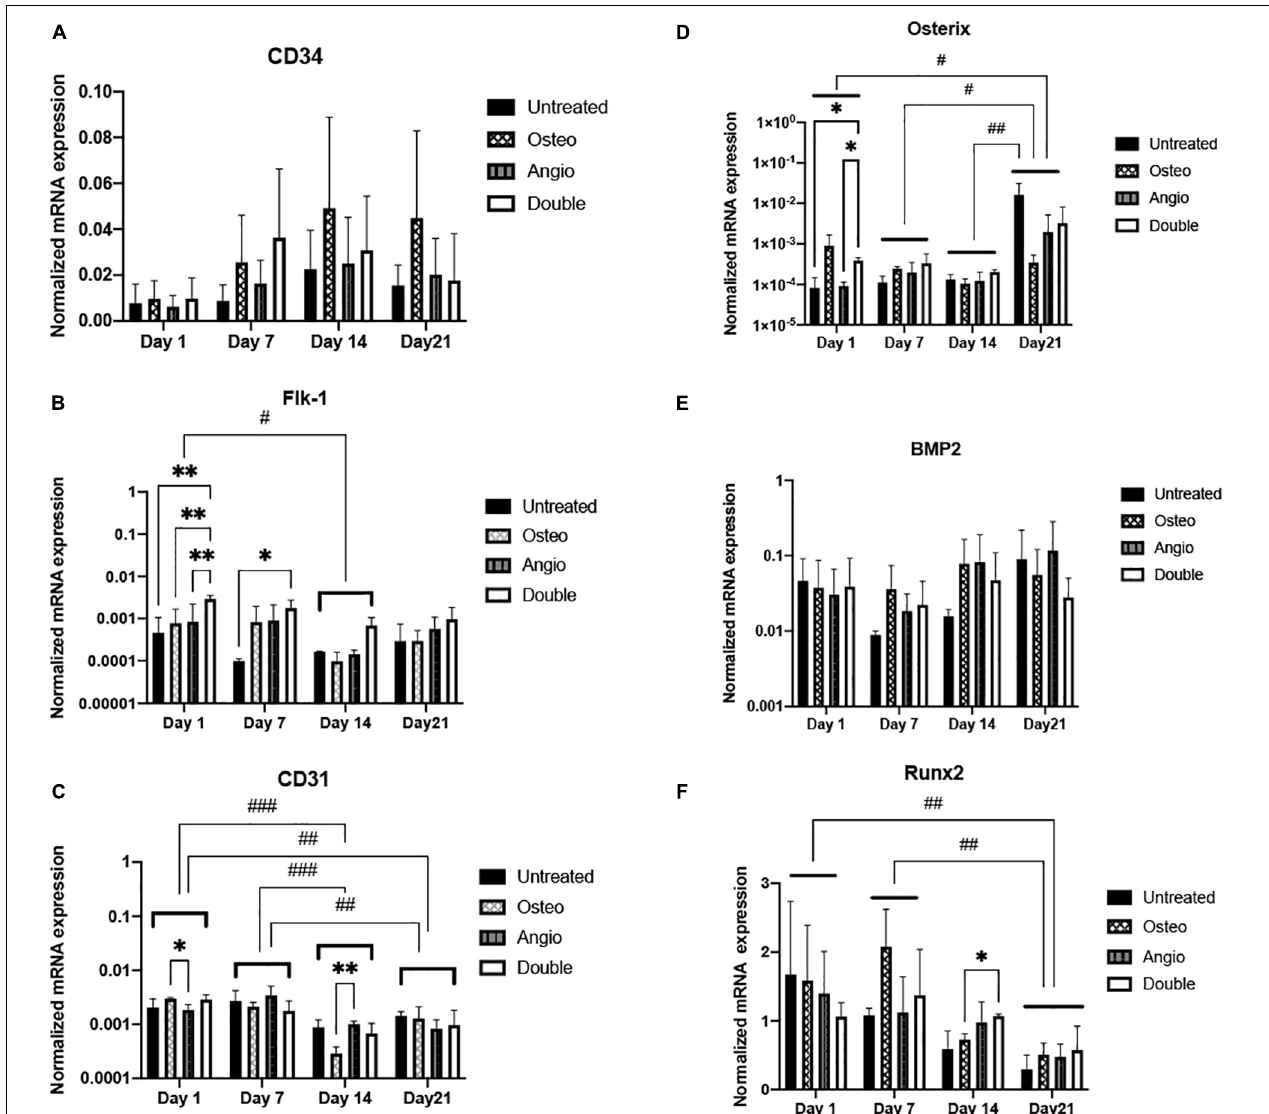
FIGURE 4 | All groups of ADSC-derived spheroids showed different dynamics of gene expression in angiogenic and osteogenic differentiation. (A) Expression of CD34 gene (early angiogenic differentiation marker) showed non-significant increase in all groups toward day 21. (B) Flk-1 (VEGF receptor 2 gene) expression decreased significantly in all groups on day 14 compared with that on day 1. (C) CD31 (mature endothelial cell marker) gene expression was significantly downregulated on days 14 and 21 compared with days 1 and 7. (D) Osterix marker showed a significantly increasing gene expression dynamics toward day 21. (E) All groups maintained consistent BMP2 gene expression. (F) Runx2 gene expression drastically regressed during 3D cultivation. Histograms represent mean ( ± SEM) gene expression levels (normalized to housekeeping genes). Two-way ANOVA describes significant differences between groups of the same time point ( ∗ p < 0.05, ∗∗ p < 0.01). Three-way ANOVA describes significant differences between time points (# p < 0.05, ## p < 0.01, ### p <